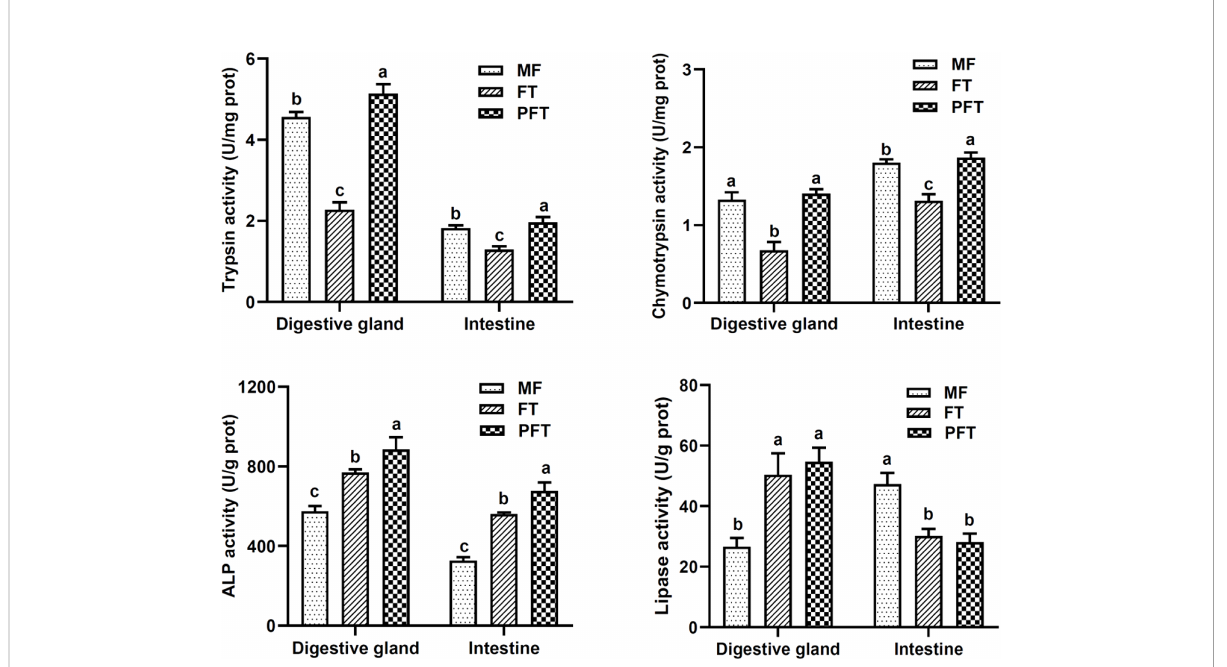
FIGURE 1 Changes of trypsin, chymotrypsin, lipase and alkaline phosphatase (ALP) in the digestive system from pre-feed transition to post- feed transition. 20 DPH, 40 DPH and 60 DPH in the fi gure correspond to the mysid feeding period (MF), feed transition period (FT), and the post-feed transition period (PFT), respectively. Different lowercase letters in tissue indicate signi fi cant differences among